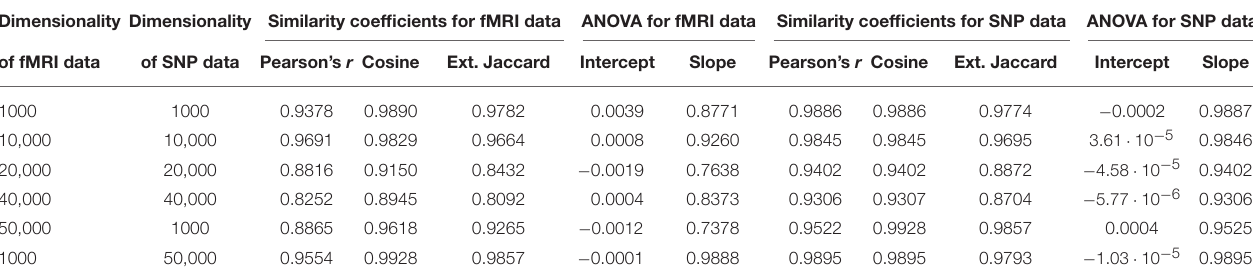
TABLE 4 | Comparison of PLSC and PLSC-RP weights for high-dimensional neuroimaging and high-dimensional SNP data. Dimensionality Dimensionality Similarity coefficients for fMRI data ANOVA for fMRI data Similarity coefficients for SNP data ANOVA for SNP data of fMRI data of SNP data Pearson’s r